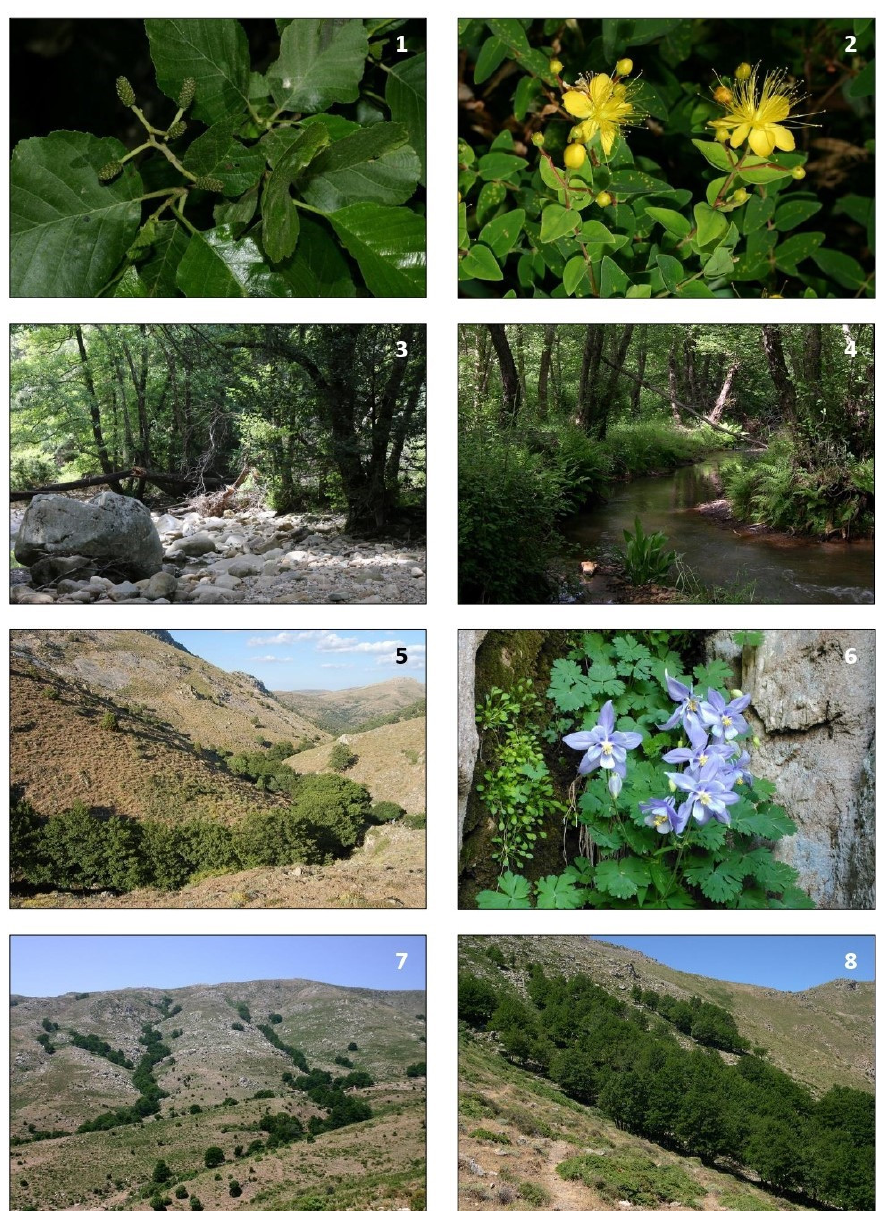
Figure 5. Plant communities and diagnostic species of the Alnus glutinosa riparian woodlands ( 1 ) in Sardinia: ( 2 ) Hypericum hircinum , characteristic species of the suball. Hyperico hircini-Alnenion glutinosae ; ( 3 , 4 ) Osmundo-Alnetum glutinosae (Rio Leni, Iglesiente—Sardinia); ( 5 ) Glechomo sardoae-Alnetum glutinosae (Rio Correboi, in the Gennargentu Mounts—Sardinia); ( 6 ) Aquilegia nugorensis , plant species of the Glechomo sardoae-Alnetum glutinosae ; ( 7 , 8 ) Glechomo sardoae-Alnetum glutinosae (Gennargentu Mounts—Sardinia). Photo credits: O. Caldarella ( 1 , 2 ), L. Gianguzzi ( 5 ), G. Bacchetta ( 3 , 4 , 6 – 8